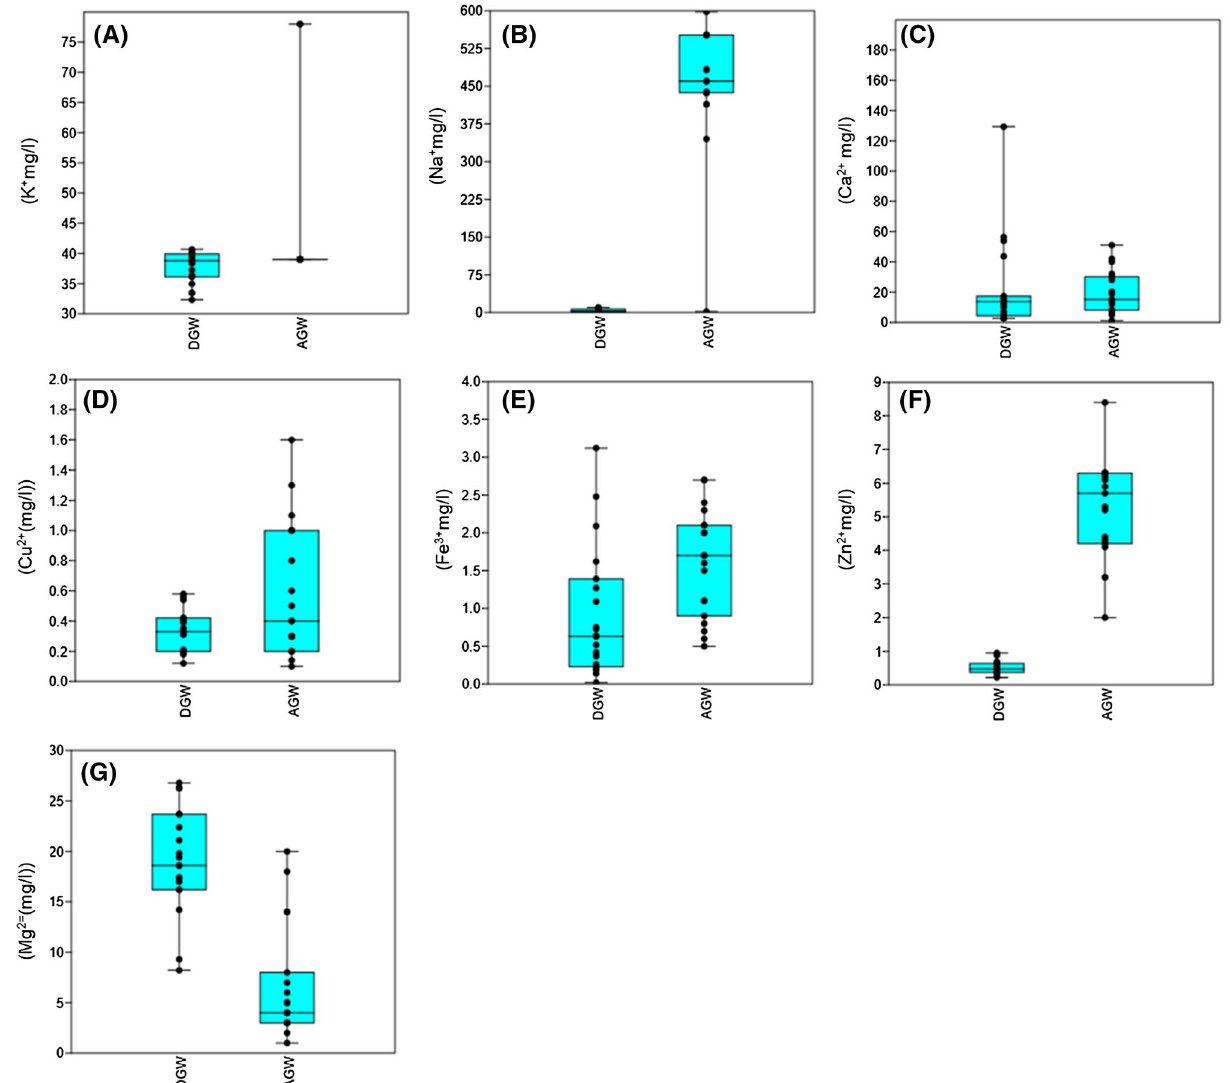
Fig. 6 Variability of cations a potassium; b sodium; c calcium; d copper; e iron; f zinc; and g